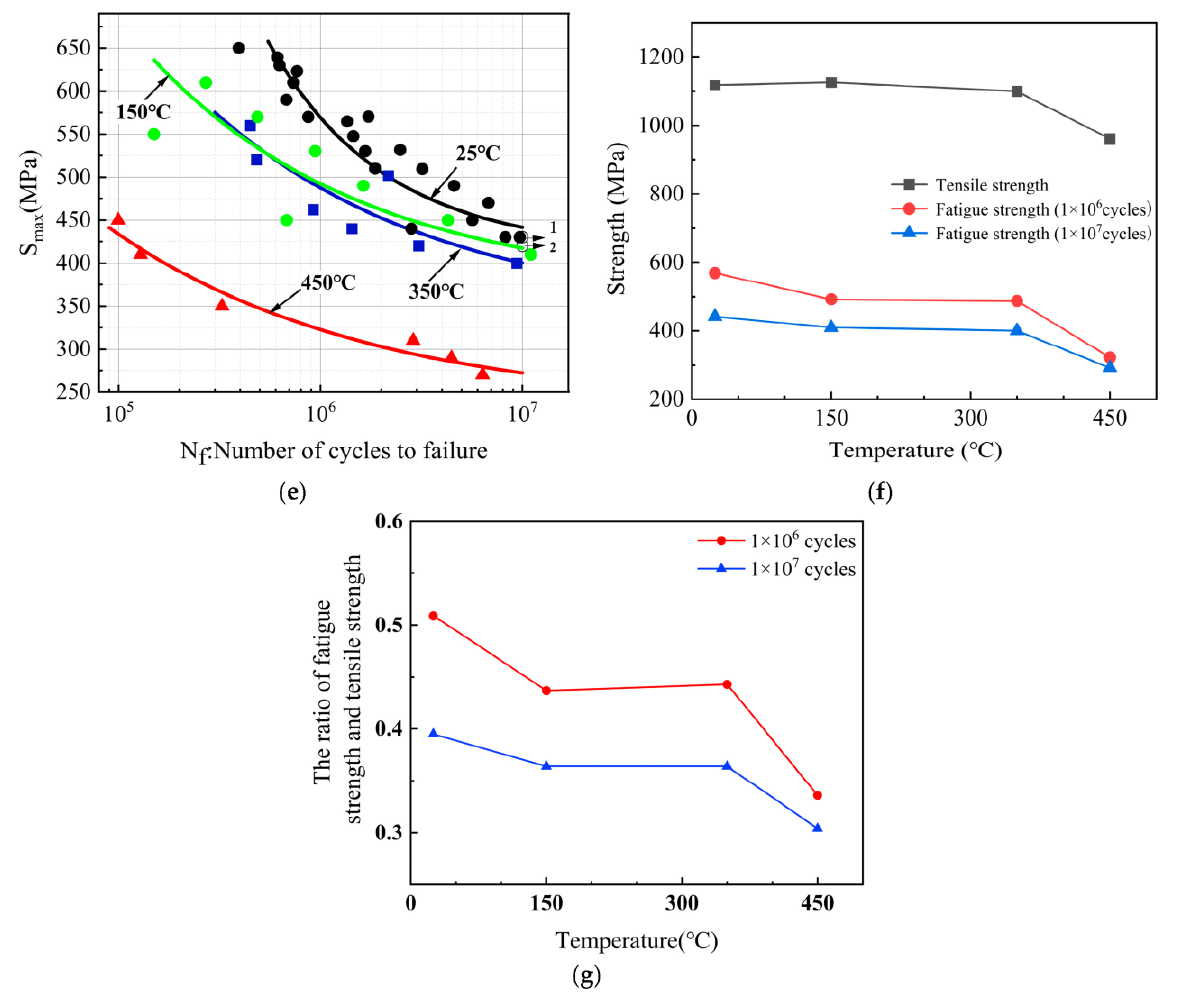
Figure 10. S-N curves of C17200 beryllium copper alloy at different temperatures. ( a ) S-N curve of C17200 alloy at 25 °C; ( b ) S-N curve of C17200 alloy at 150 °C; ( c ) S-N curve of C17200 alloy at 350 °C; ( d ) S-N curve of C17200 alloy at 450 °C; ( e ) S-N curves of C17200 alloy at different tempera- tures; ( f ) comparison of fatigue strength of C17200 alloy at different temperatures at 1 × 10 6 cycles and 1 × 10 7 cycles; and ( g ) ratio of fatigue strength to tensile strength of C17200 alloy at different temperatures.